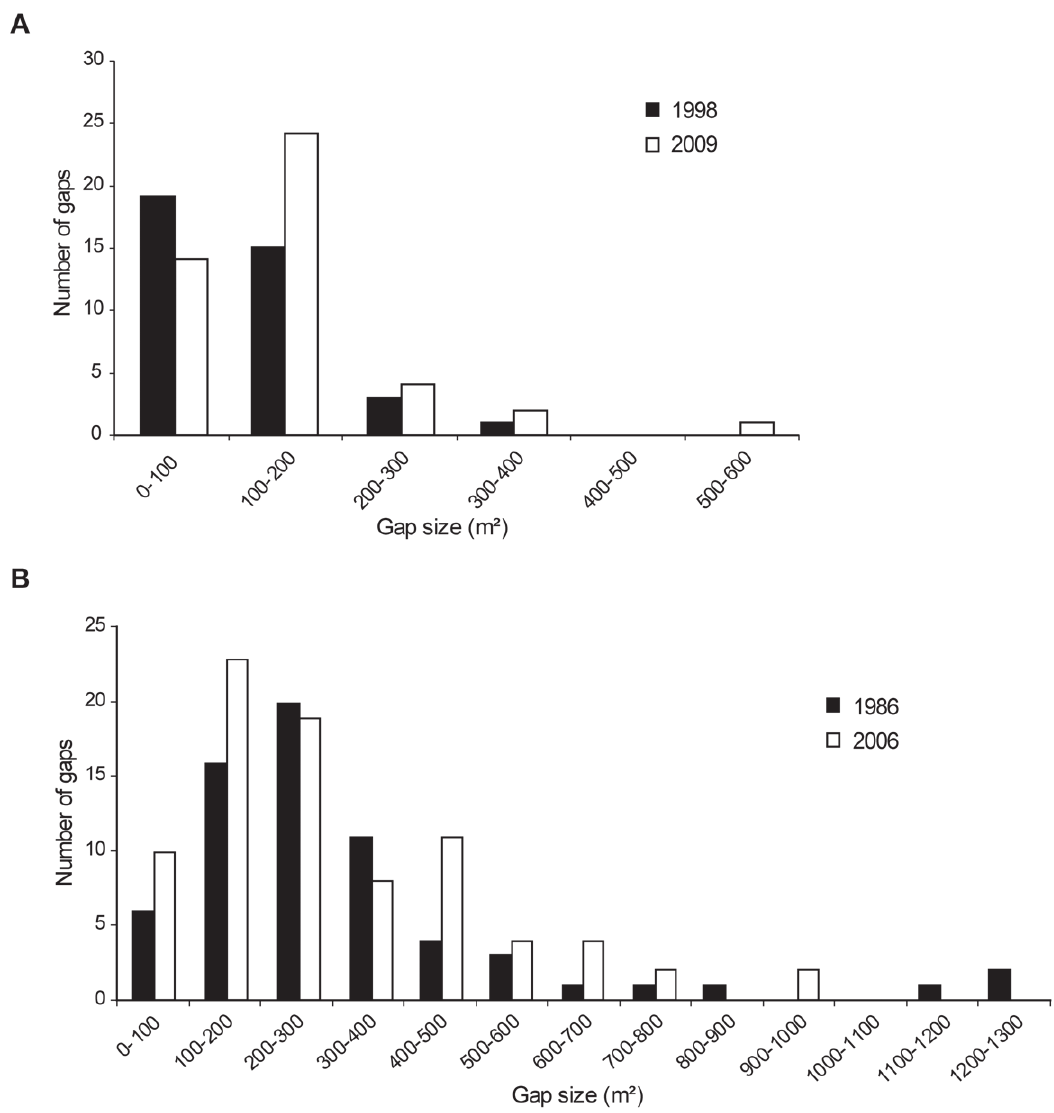
Figure 1. Gap size distribution in the Kopa (A) and Gorjanci (B) forest reserves. doi:10.1371/journal.pone.0052641.g001 PLOS ONE | www.plosone.org